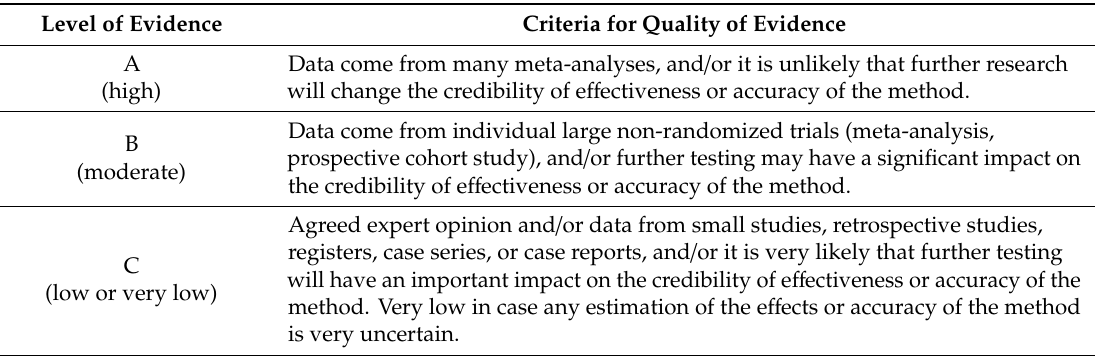
Table 2. GRADE-adopted classification.